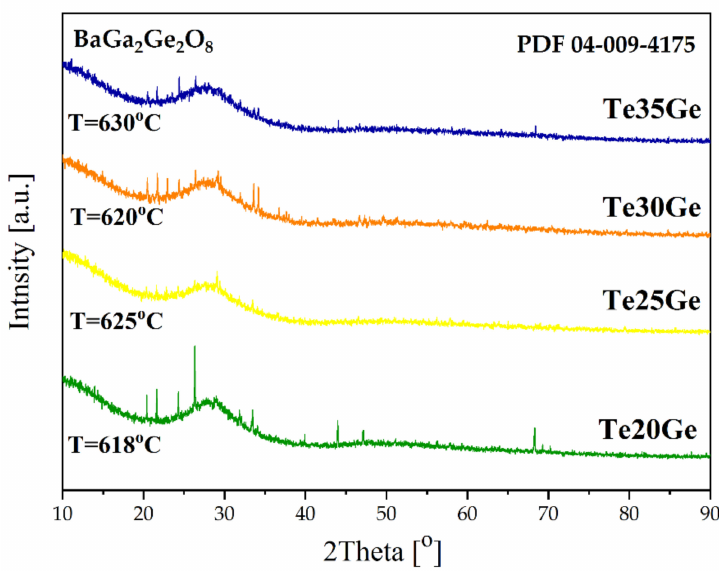
Figure 3. Diffraction patterns of Eu 3+ -doped Te20Ge, Te25Ge, Te30Ge, and Te35Ge glasses in maxi- mum temperature of crystallization peaks.